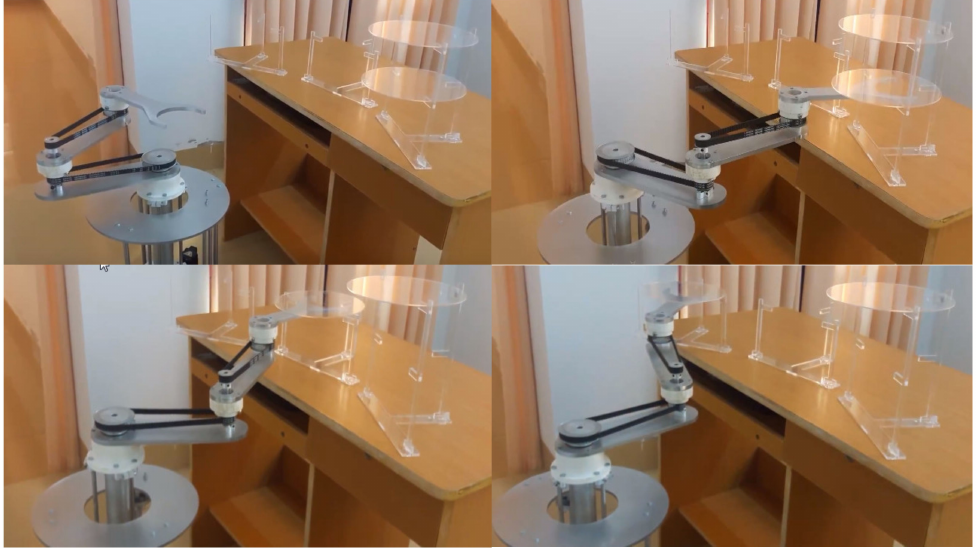
Figure 22. Experimental results for the proposed design in an open